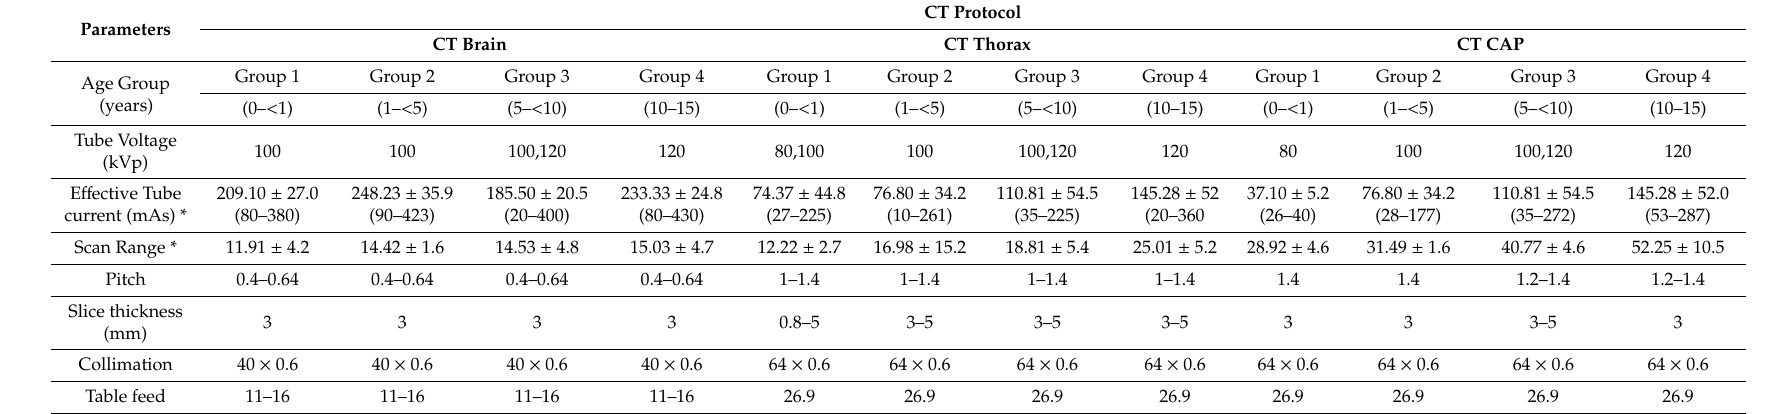
Table 2. Parameters used in CT brain, thorax, and